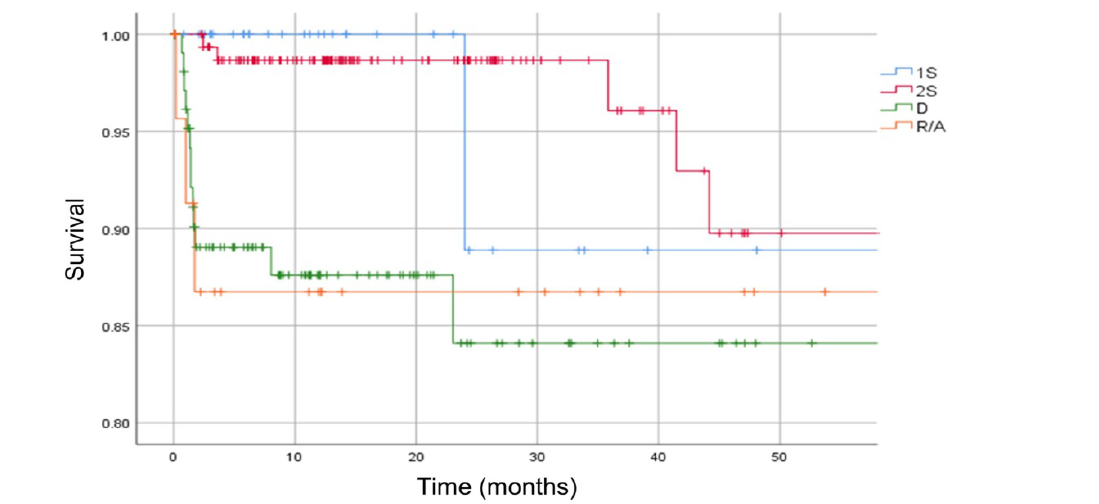
Figure 7. Kaplan-Meier survival curve. The analysis is separated in different types of surgical treatment. Vertical marks indicate censoring. 1S = one-stage exchange, 2S = two-stage exchange, D = debridement, R/A = removal or